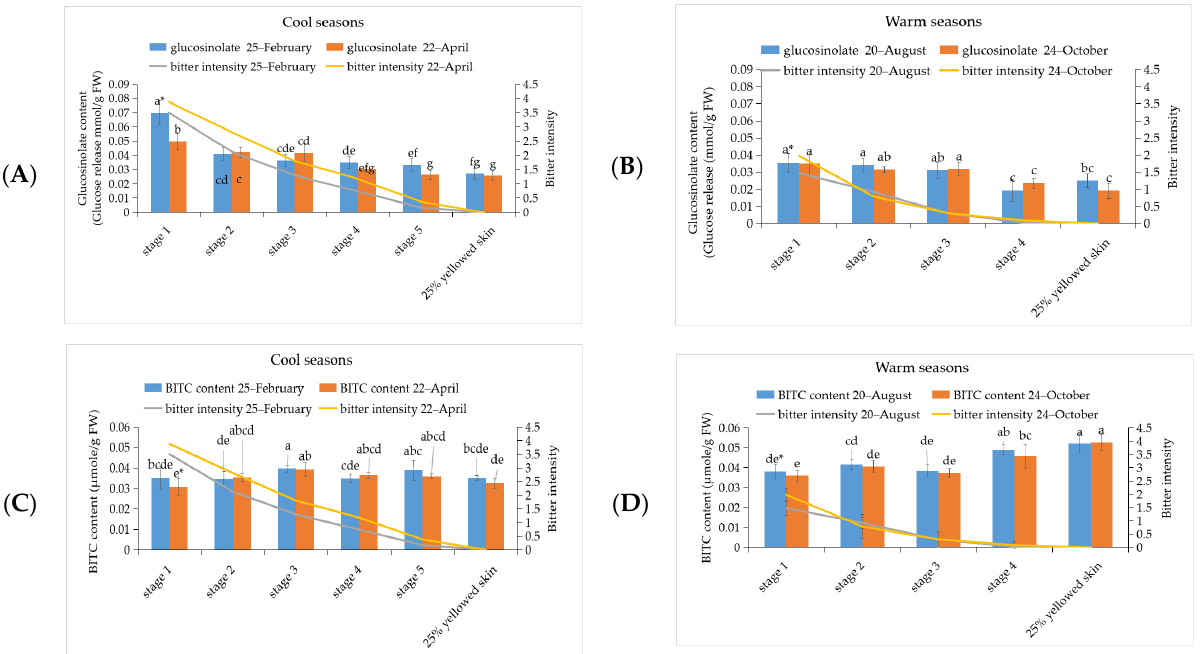
Figure 3. The correlation of glucosinolate content ( A , B ) and BITC content ( C , D ) with bitterness intensity in different maturity stages of papaya fruit during cool and warm seasons. Data are mean ± SD, n = 4. * Mean statistical data within a column were obtained by Duncan’s test at the 5% level (same letters means no significannce).